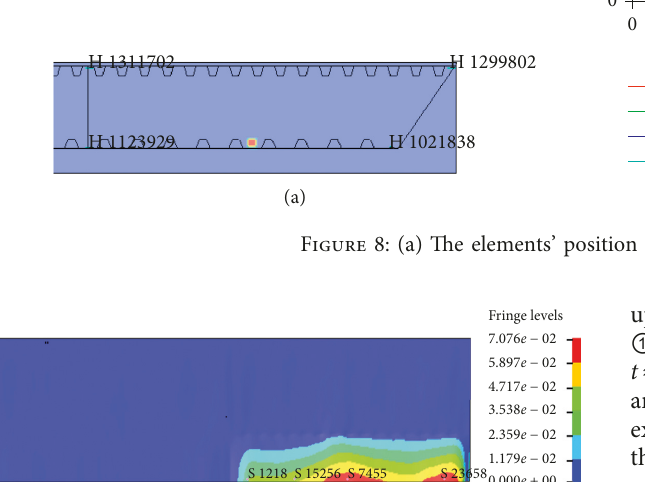
Figure 9: Fringe plot of displacement and the elements’ position of the deck (top view, unit: m).